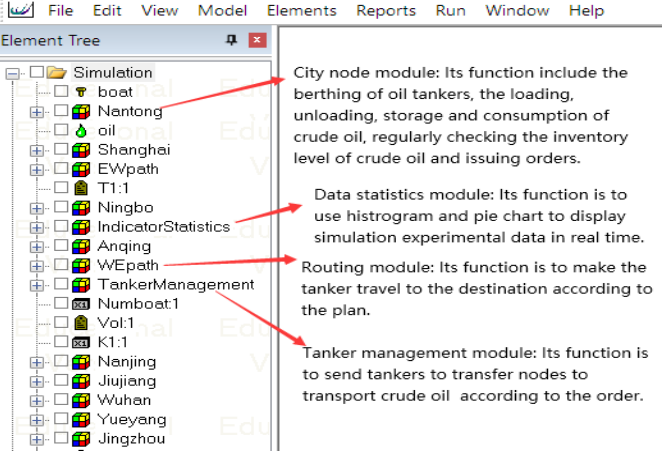
Figure 6. Module library in the system simulation model.